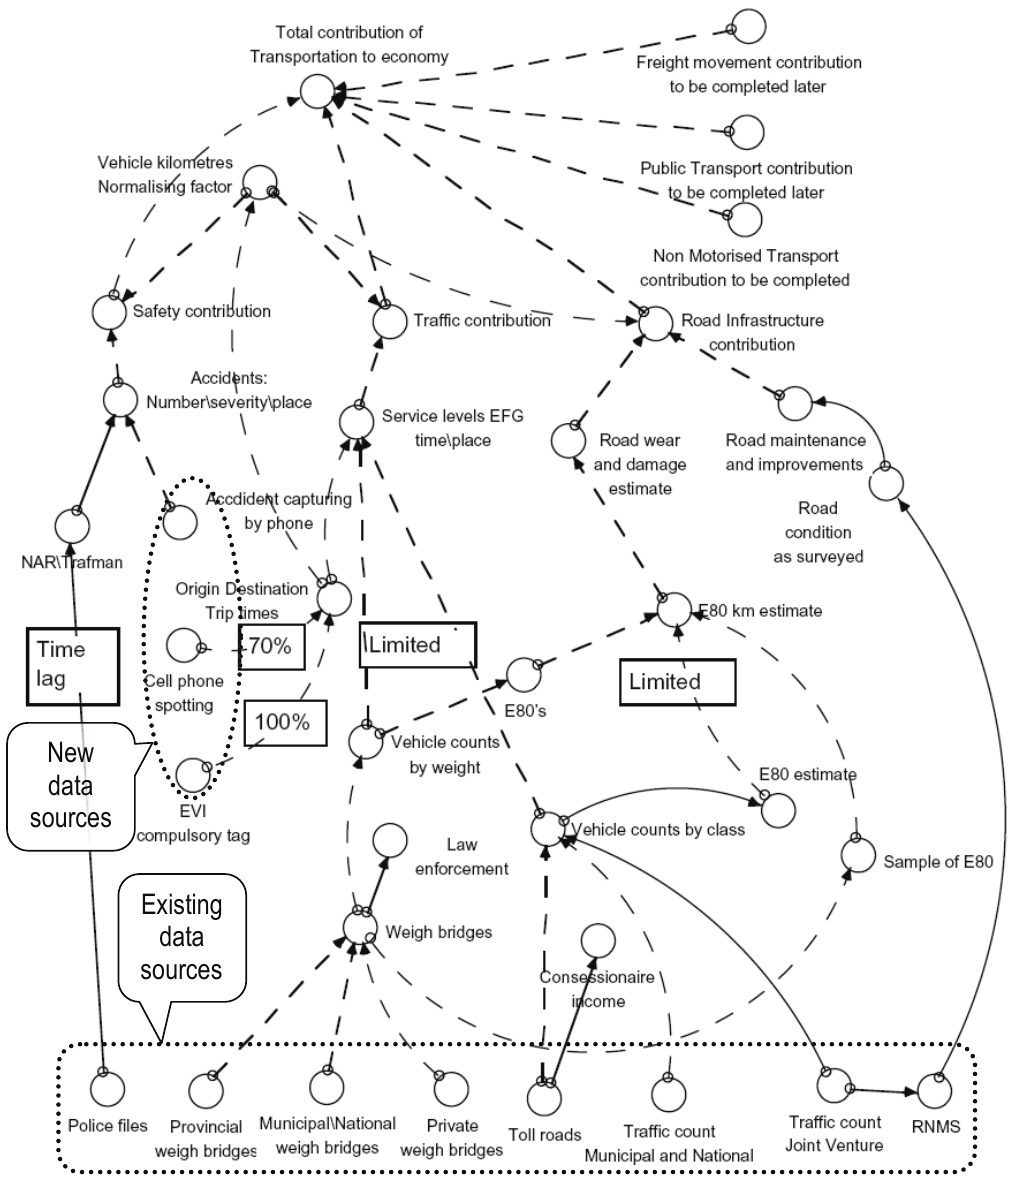
The scope of the proposed transportation